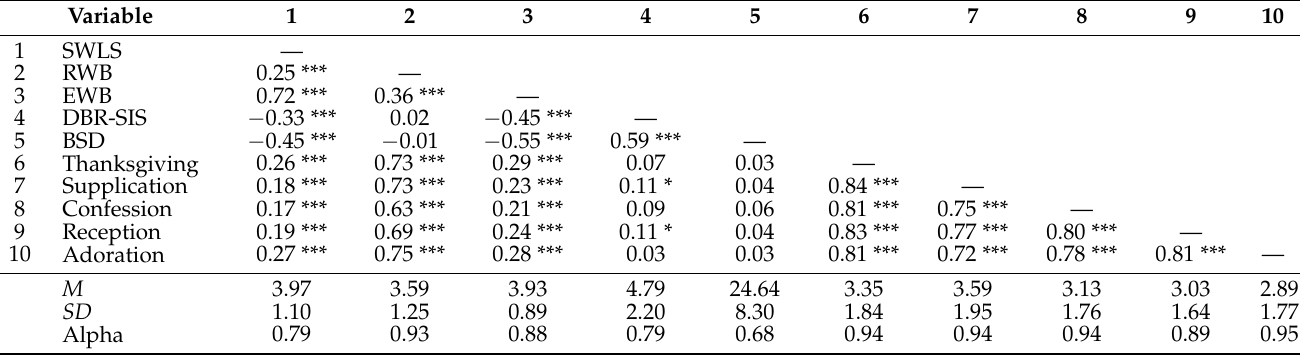
Table 5. Intercorrelations, Means, Standard Deviations, and Alphas for the Variables of Interest ( N =